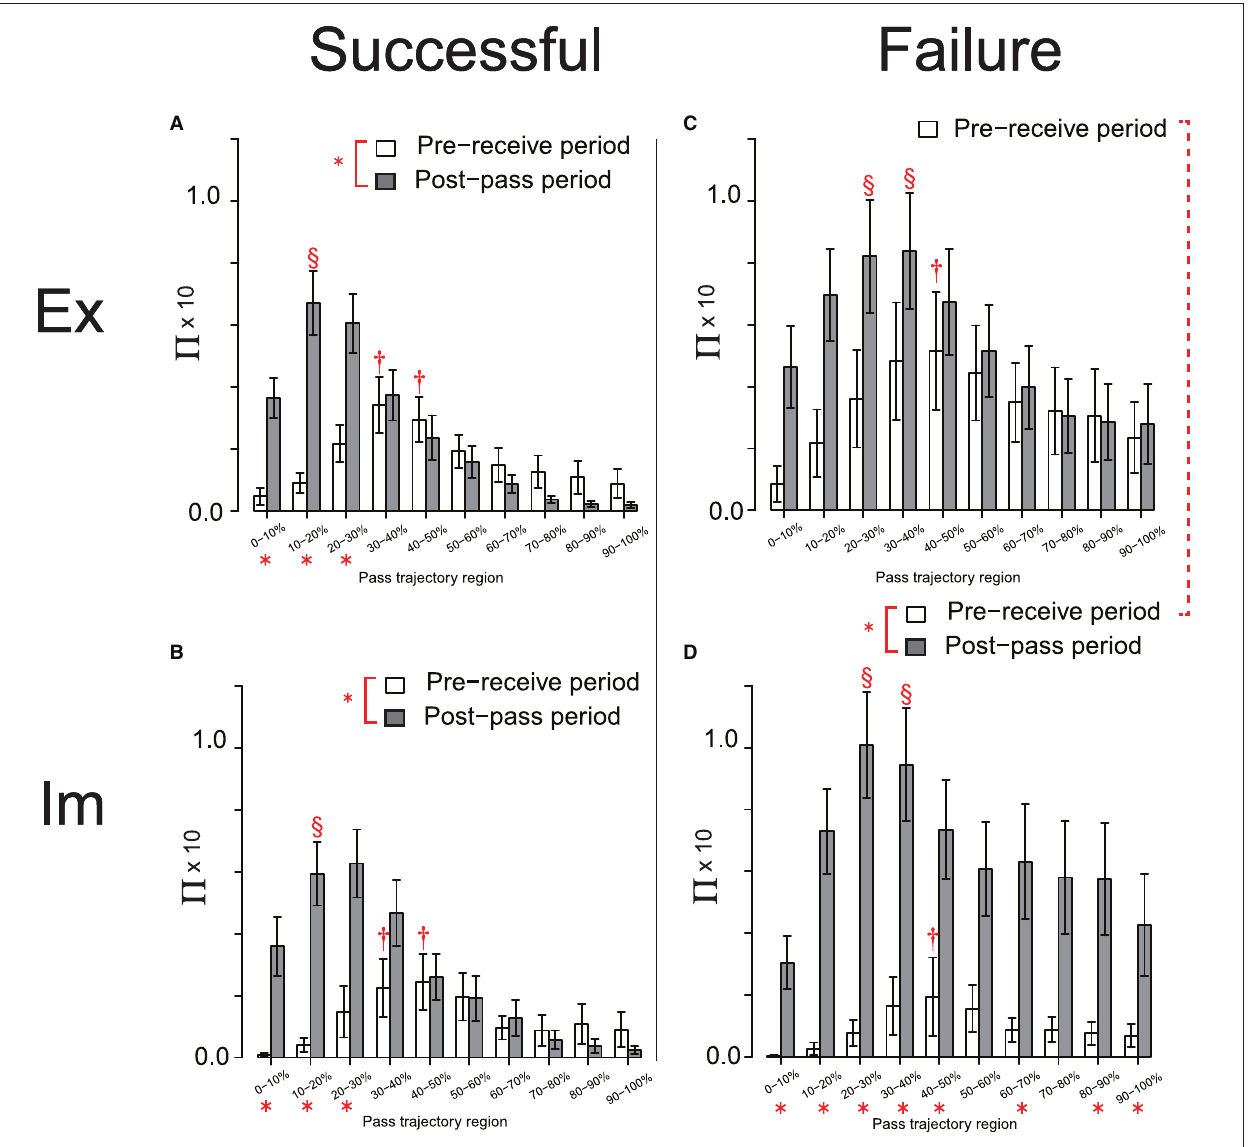
FIGURE 5 | 5 distribution on the pass-trajectory regions calculated for the Ex group for successful (A) and failed (C) passes, and those for the Im group [ (B, D) , respectively]. *indicate significant simple main effects of the action phase of the attackers. The red broken line connecting the legends indicates the trend for the significant simple main effects of the group ( p = 0.09). Results of the post-hoc test on the simple main effect of the pass-trajectory regions in each action phase are represented by † and § . In (A) and (B) , † indicates significantly higher values than those in 0–20%, and § indicates a significantly higher value than those in all regions except for 10–20%. In (D) , † indicates significantly higher values than those in 0–20% and the two § indicate significantly higher values than those in all regions except for 10–20% and